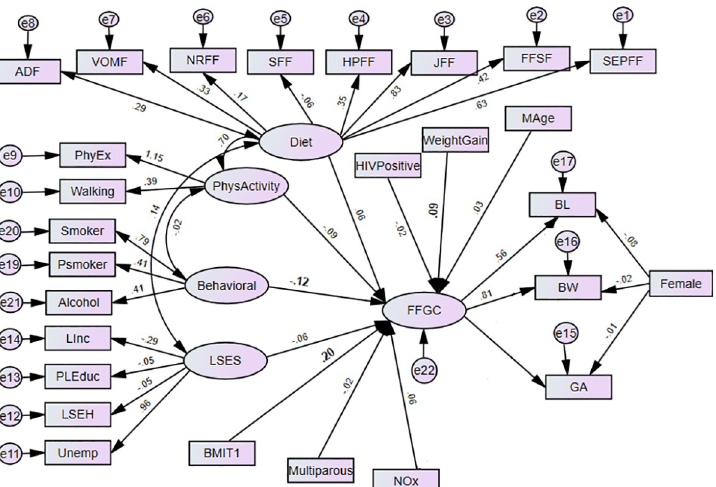
Fig 2. The effects of prenatal exposure characteristics on birth outcomes (BW, BL, GA) with FFGC as a mediating latent variable (Model 2) BW-Birthweight; BL-Birth Length; GA- Gestational Age; NOx- Oxides of Nitrogen; GWG- Gestational Weight Gain; BMIT1- Pre-gestational body mass index; and Mage- maternal age. Latent variables: dietary factors (EFSF- energy foods and snacks; FFSF-spreads and fast foods; JFF- junk foods factor; PRFF- protein-rich foods; SFF- starch foods; NRFF-nuts and rice foods; VRFF-vegetable-rich foods; and ADF-alcoholic drinks); PhyEx- physical exercise; PSmoker- passive smoker; LSES -low socio-economic status, Linc- Low income; PLEduc- primary or less education; LSEH-Low socio-economic housing; Unemp- unemployed.